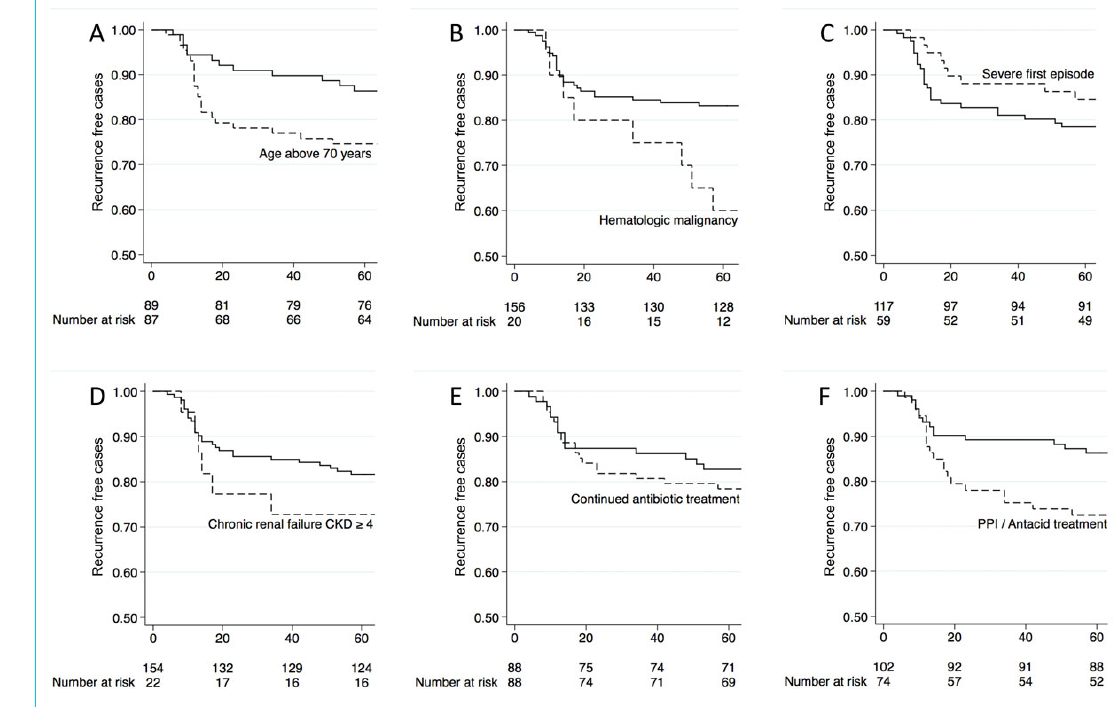
Without recurrence n = 141 (80%)